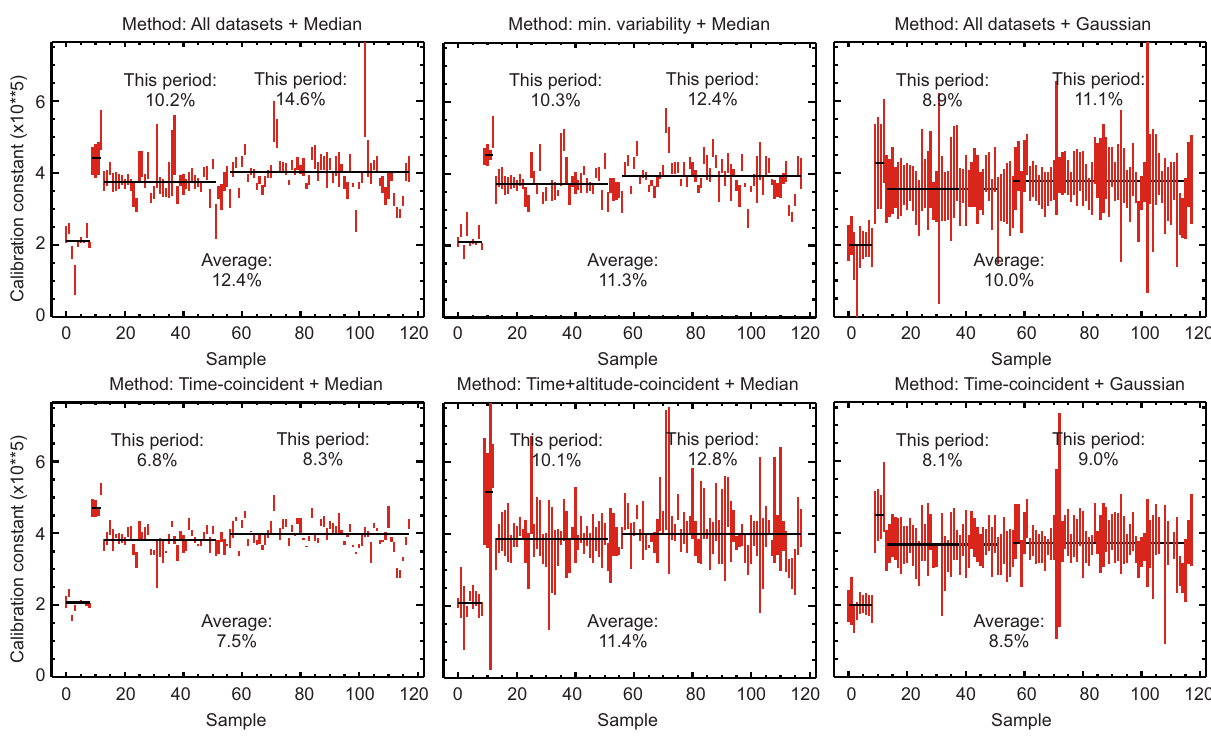
Fig. 5. Six examples of the 12 calibration methods tested. The percentages represent the standard deviations of the calculated calibration constants over 2 sub-periods and averaged over the entire 118 samples (October 2007 to April 2009). See text for details on each method, and Table 2 for a compilation of the standard deviations of all 12 methods. Table 2. Standard deviation of the lidar calibration constant calculated 120 2-h-long samples over the period October 2007–April 2009 using 12 different calibration methods (single radiosonde coincidences). See text for